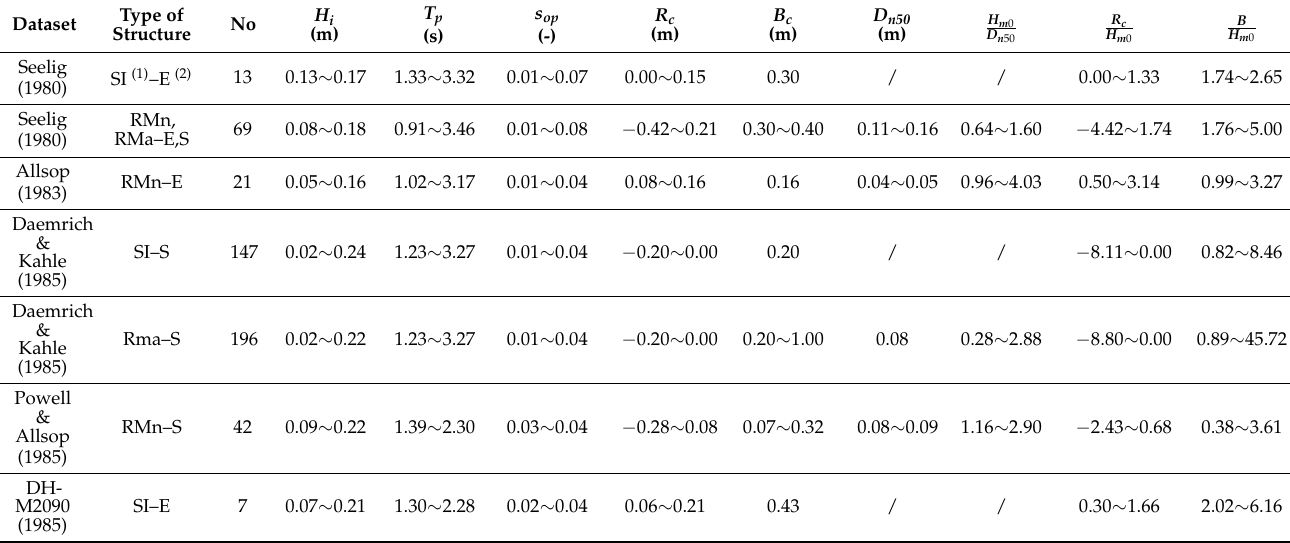
Table 3. Characteristics of the existing Data